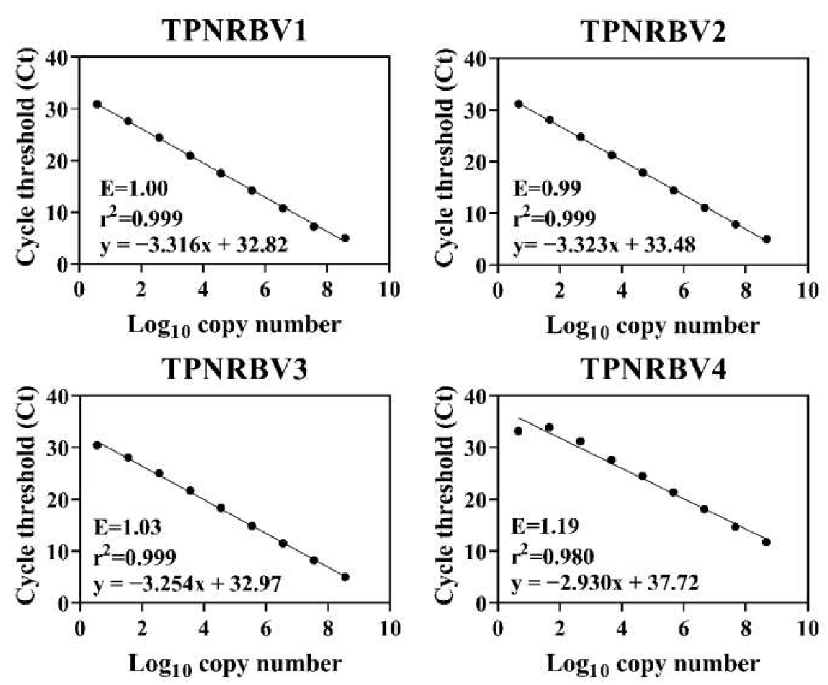
Figure 2. Standard curves of TPNRBV determined using RT − qPCR.